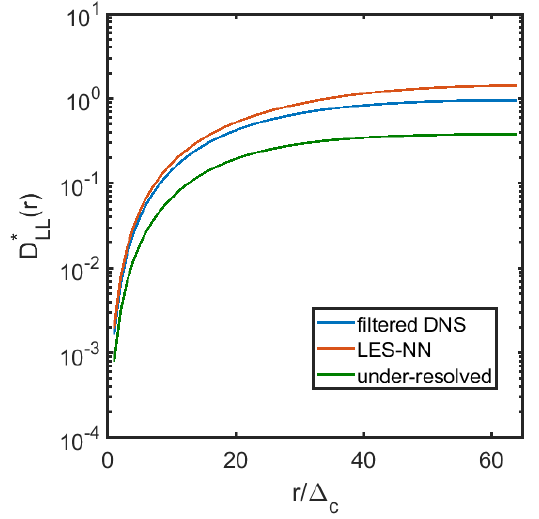
Figure 11. The second-order nondimentional longitudinal structure function D ∗